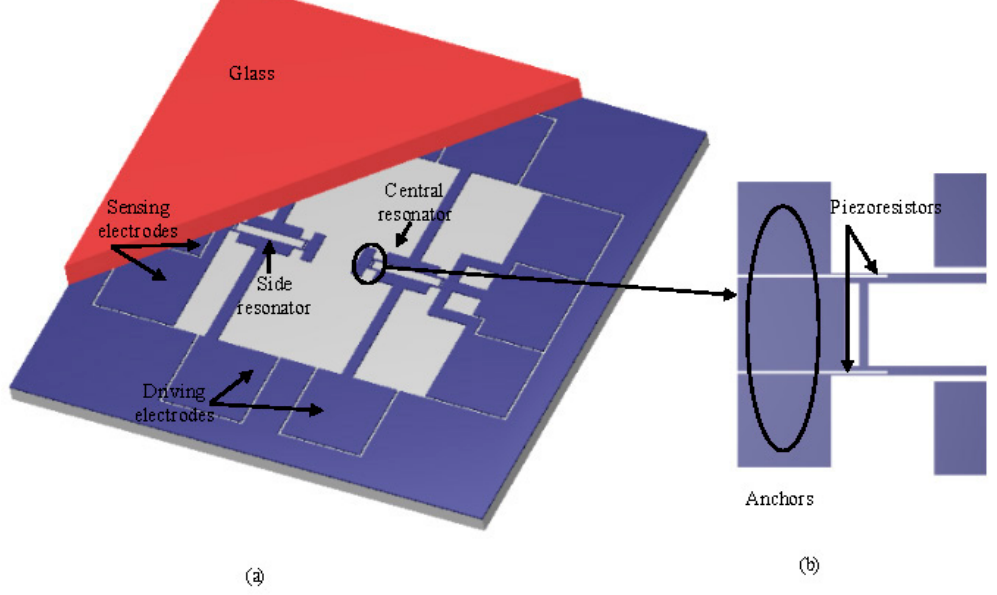
Figure 1. Schematic of the resonant pressure micro-sensor ( a ) relying on electrostatic excitation and piezoresistive detection ( b ) where double-ended tuning forks were used as